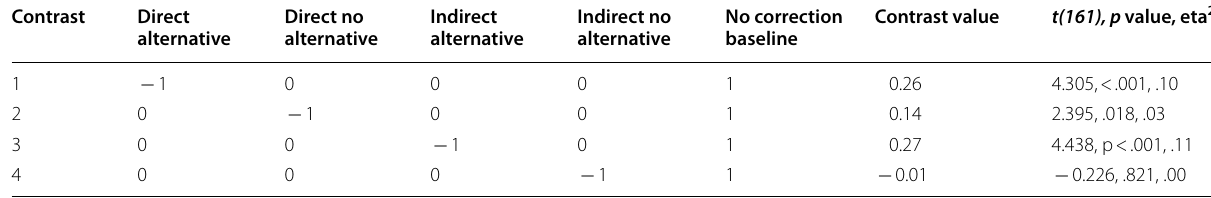
One-way ANOVA, F (4, 161) 13.183, p < .001 = Table 8 Summary of Contrast Analyses to Test for CIE Elimination in Experiment 2. Contrast Values Refer to Difference in Mean Proportion of (Mis)information Responses Between an Experimental Condition and the No (Mis)information Baseline Condition